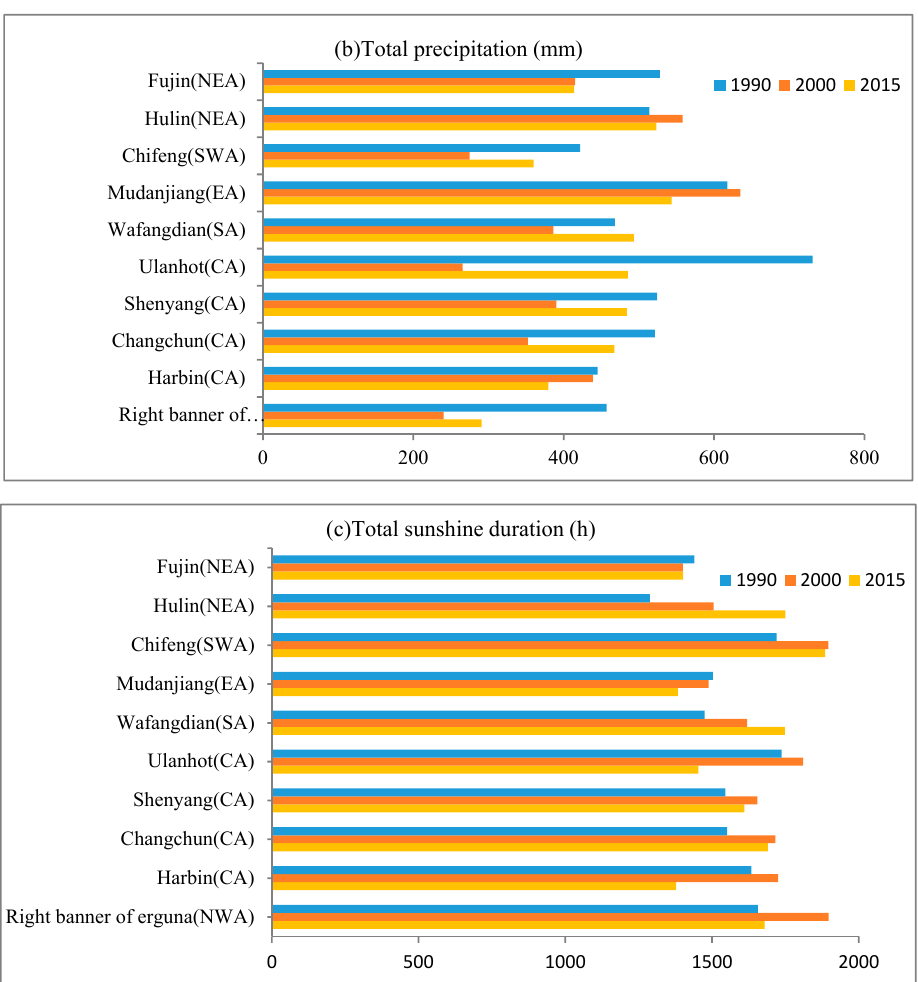
Figure 9. The variation of three meteorological factors for the 10 stations during the maize growth period from 1990 to 2015 in Northeast China. ( a ) Mean temperature; ( b ) Total precipitation; ( c ) Total sunshine duration.